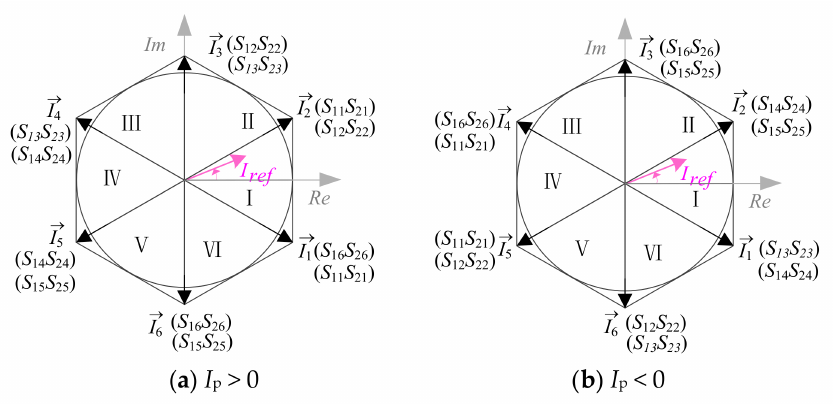
Figure 2. Current space vector. ( a ) I p > 0 ( b ) I p < 0. Table 1. The corresponding switch state of the space vector. Space